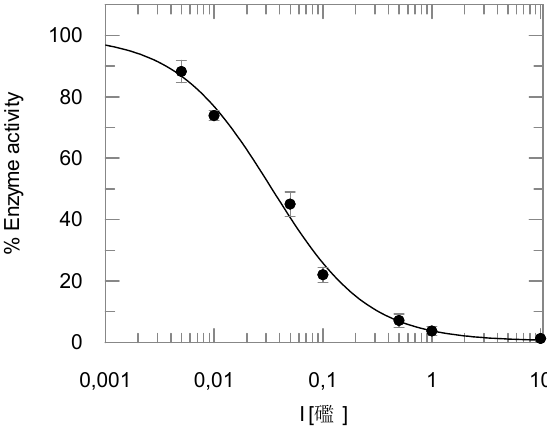
Figure 2. Inhibition of rhodesain by compound 8 .